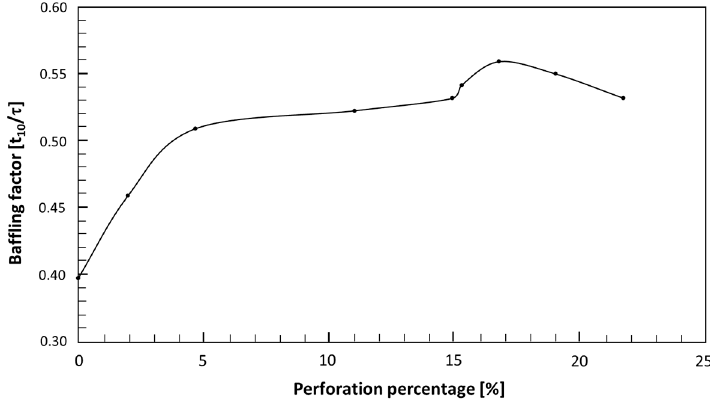
Figure 7. Variation of the baffling factor t 10 / τ value with the perforation percentage.